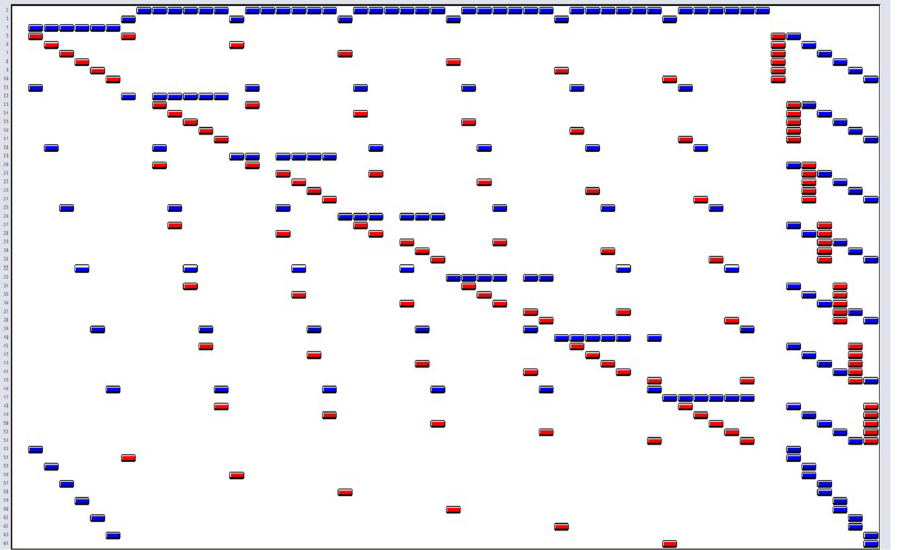
Figure 5. Fill-in approach to the model matrix.